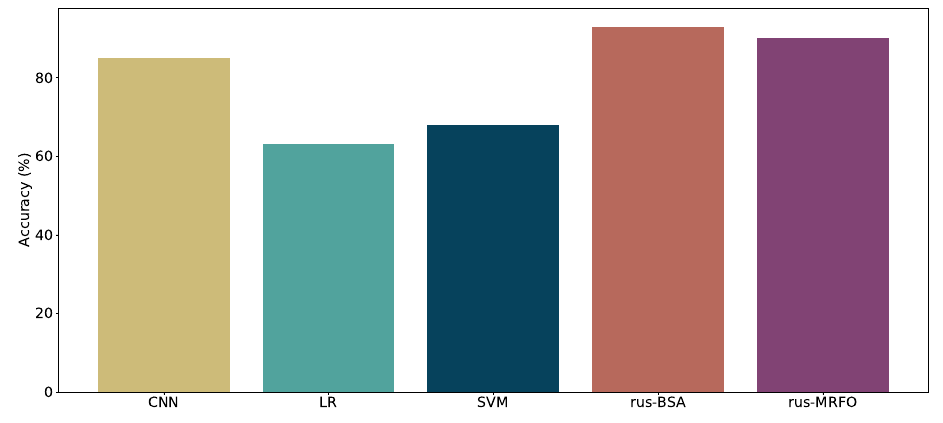
Figure 7. Accuracy Techniques.